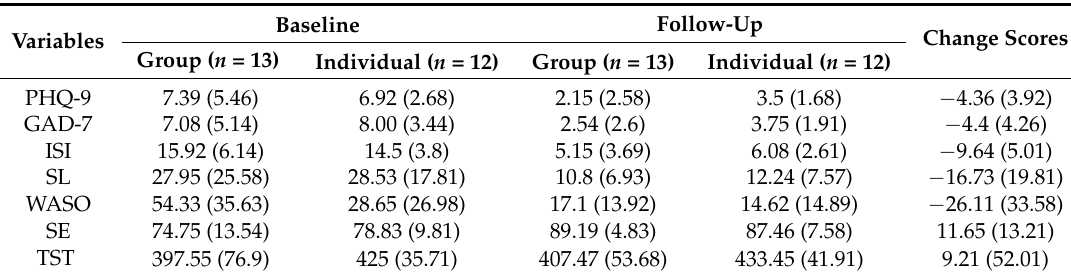
Table 1. Means and Standard Deviations by